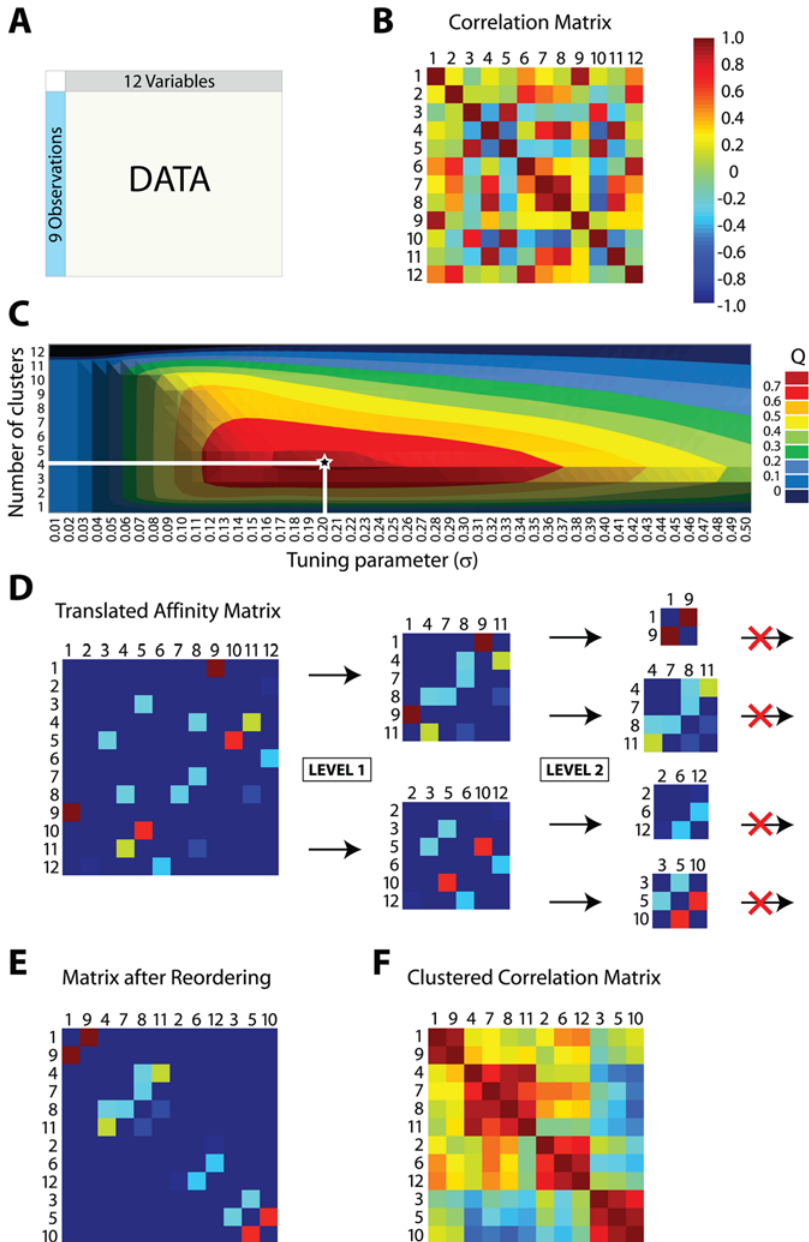
Figure 3. Modulated modularity clustering. Panels (A)–(F) illustrate the method of modulated modularity clustering by example. (A) Example data consisting of nine observations on twelve variables drawn from a standard multivariate Normal distribution with variance-covariance matrix given by the correlation matrix from Figure 2. The variables have been permuted so that the block structure of the data will be obscured. (B) Heat map showing the pairwise correlations between variables (numbered 1 through 12 after permutation). The color scheme was introduced in Figure 2. (C) Surface plot of the maximum modularity attainable for a fixed number of clusters as s varies. The 4,213,597 possible partitions of the twelve variables are grouped by number of parts (and hence clusters), and the maximum modularity Q found among these is shown on the plot for each s . The surface appears convex and attains its maximum Q ~ 0 : 7095 at s ~ 0 : 203 (on a grid of step size 0.001) for a clustering of size 4. For larger examples, it is not possible to enumerate all partitions, and an approximate method is used to marginally maximize Q in s . (D) The optimal s defines the graph whose community structure is to be evaluated. The graph has affinity matrix with entries e r j j { 1 ð Þ = s 2 ; for illustration, these values have been shifted and linearly scaled so that the previously introduced heat map applies. To identify the partition of maximum modularity, we use a greedy forward search in which the initial graph is recursively bisected into subgraphs until the overall modularity can no longer increase. In the figure, each level (LEVEL 1, LEVEL 2) indicates a round of bisection, and each subgraph is represented by its corresponding section of the affinity matrix. There is no third level; subsequent to the second round, the overall modularity cannot be increased through further bisection. (E) The resulting clustering is used to reorder the affinity matrix by permutation of its rows and columns. Entries with colors other than dark blue have now been aggregated along the main diagonal. (F) Applying the same permutation to the correlation matrix reveals the four correlated clusters of variables ({1,9},{4,7,8,11},{2,6,12},{3,5,10}) hidden within the data.